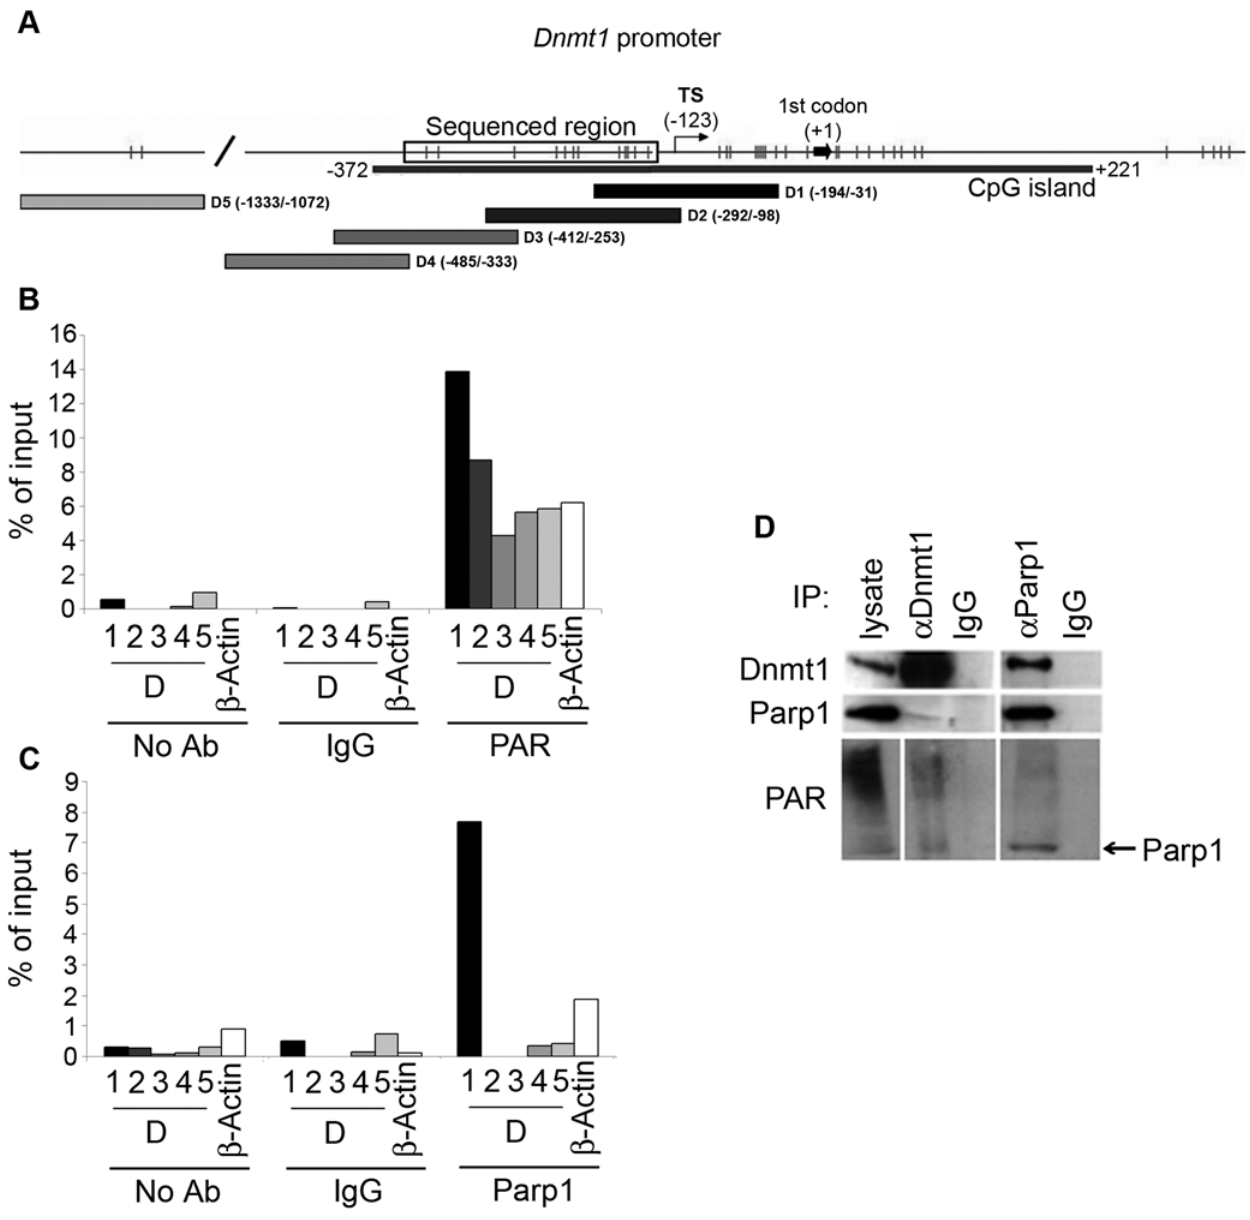
Figure 4. ChIP analysis of Dnmt1 promoter occupancy by PARs and Parp1. A, Schematic representation of the Dnmt1 promoter region with approximate locations of the amplicons used to detect the presence of Dnmt1 sequences in ChIP complexes. ChIPs were carried out with anti-PAR (B) and anti-Parp1 (C) antibodies. Controls were non-specific normal rabbit IgGs (IgG) or no antibody (No Ab). DNA was amplified by real-time PCR with primer sets for the amplicons indicated in A; a primer set for the b -actin promoter was used as control. Numbers refer to distance in base pairs from the first codon. Data are expressed as percentage of the signal detected for the non-immunoprecipitated input (4% of the chromatin subjected to immunoprecipitation) taken as 100%. D, Western Blot analysis of samples immunoprecipitated with either anti-Parp1 or anti-Dnmt1 antibodies; anti- PAR antibody was used to detect polymers in the immunoprecipitated complexes.